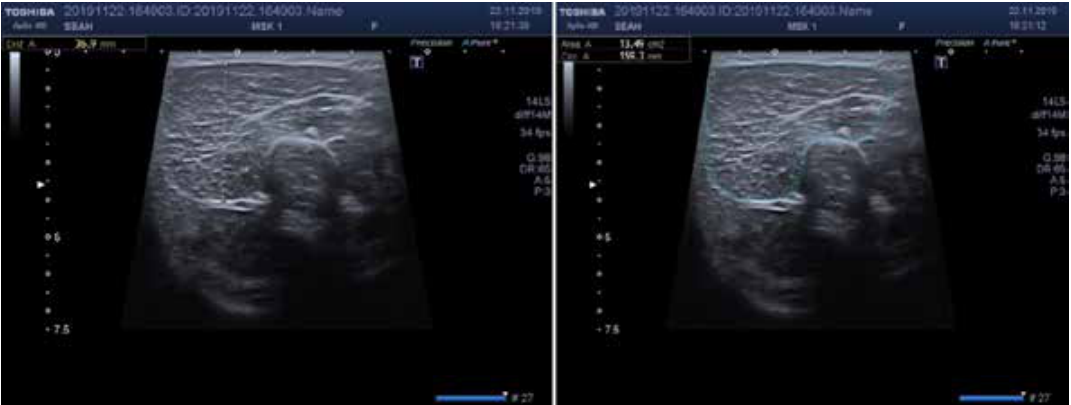
Figure 1. Muscle Thickness and CSA